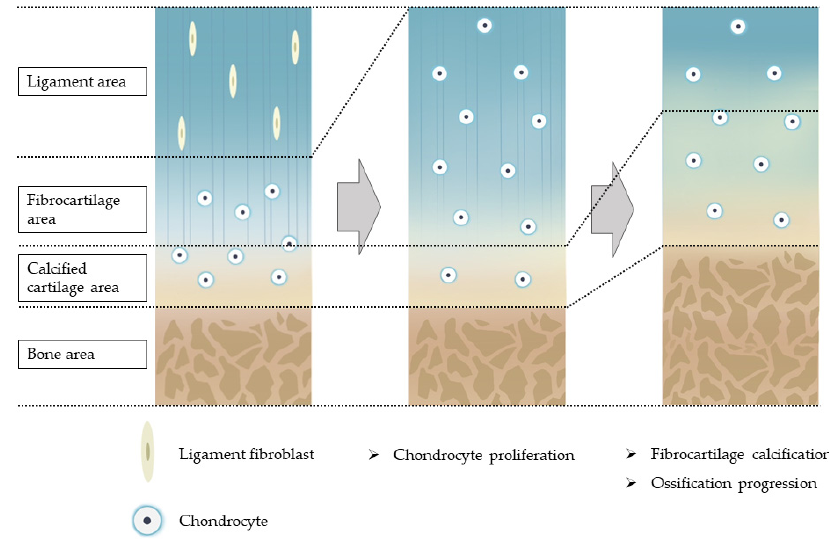
Figure 1. Hypothesis of the pathogenesis of ossification of the spinal